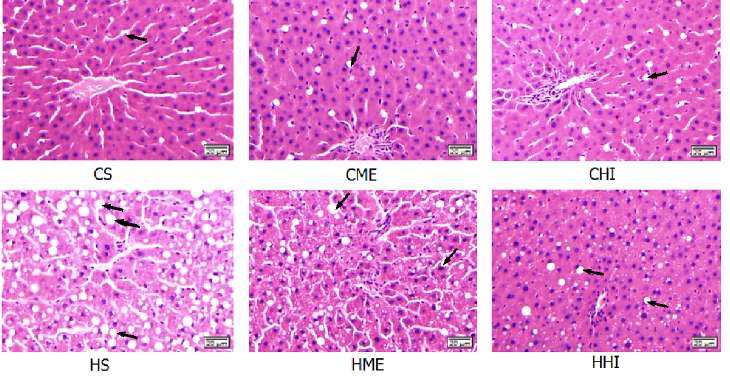
Fig 3. Histological changes in livers of rats in the six groups after the 10-weekinterventions. The vacuolesmarked by arrows indicateneutral lipid staining. H&E staining of 4 μ m sections. Scale bar = 20 μ m. CS = control diet and sedentary; CME = control diet with ME exercise; CHI = control diet with HI exercise; HS = high-fatdiet and sedentary; HME = high-fatdiet with ME exercise; HHI = high-fat diet with HI exercise.